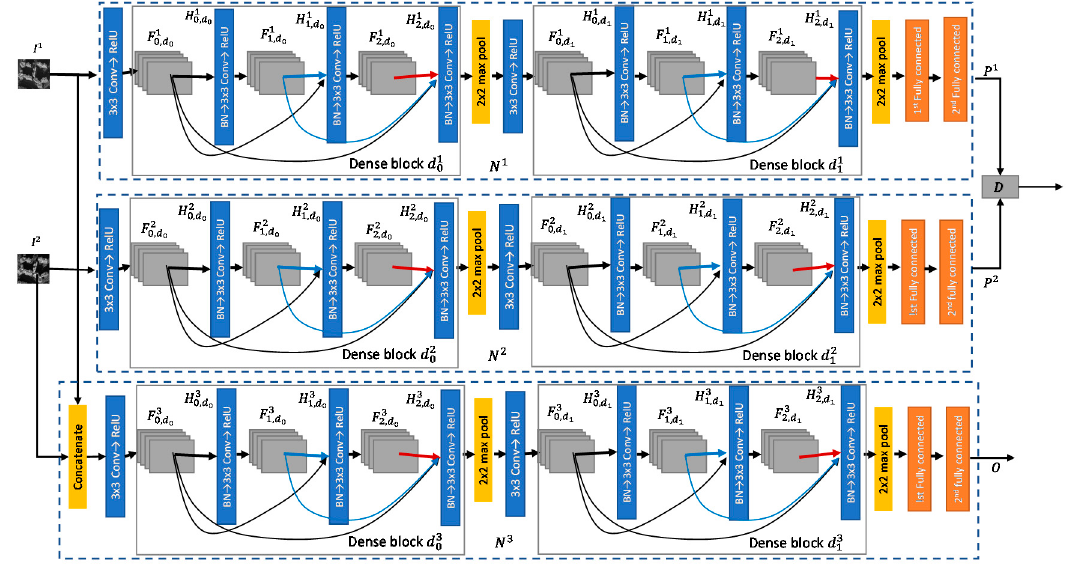
Figure 3. The proposed fusion network architecture for change detection.